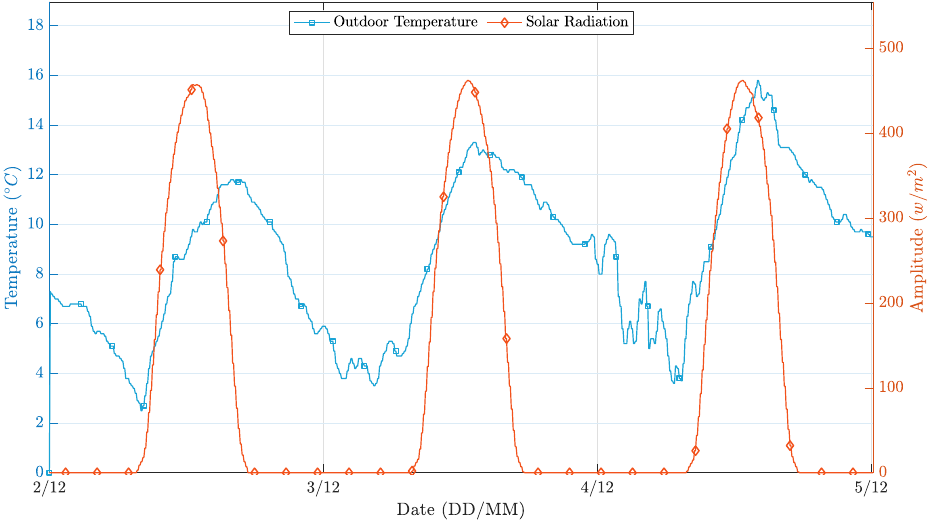
Figure 6. House temperature variation during the simulation time for PP and on-off controllers.